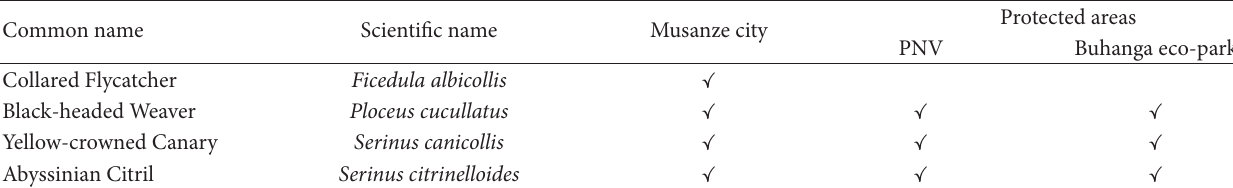
Table 5: Exotic birds in Musanze city, PNV, and Buhanga